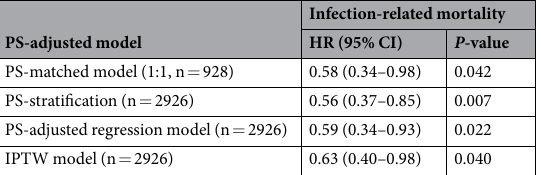
Table 3. Association between treatment with phosphate-binders and infection-related mortality. The HR was estimated using Cox proportional hazard model. In the multivariable model, age, sex, presence of diabetes mellitus and comorbidity, dialysis history, dialysis time per session, Kt/V for urea, normalized protein catabolic rate, body mass index, cardiothoracic ratio, systolic blood pressure, blood hemoglobin level, serum levels of urea nitrogen, creatinine, albumin, total cholesterol, C-reactive protein, corrected calcium, phosphate, alkaline phosphatase, and parathyroid hormone, and use of erythrocyte stimulating agents, anti-hypertensives, and vitamin D receptor activators were included. PS was created by logistic regression analysis using all the parameters listed here. A two- tailed P -value less than 0.05 was considered statistically significant. Abbreviations: CI, confidence interval; HR, hazard ratio; IPTW, inverse probability of treatment weighting; PS, propensity score.